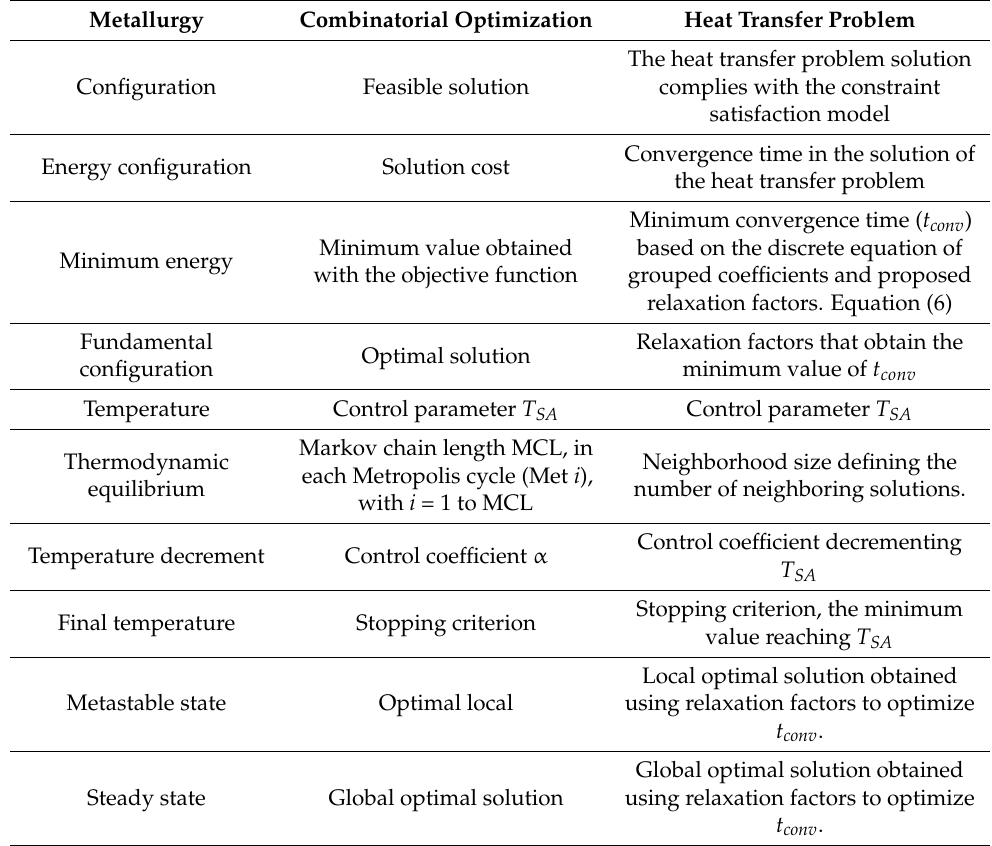
Table 1. Analogy between the simulated annealing process in metallurgy and simulated annealing in combinatorial